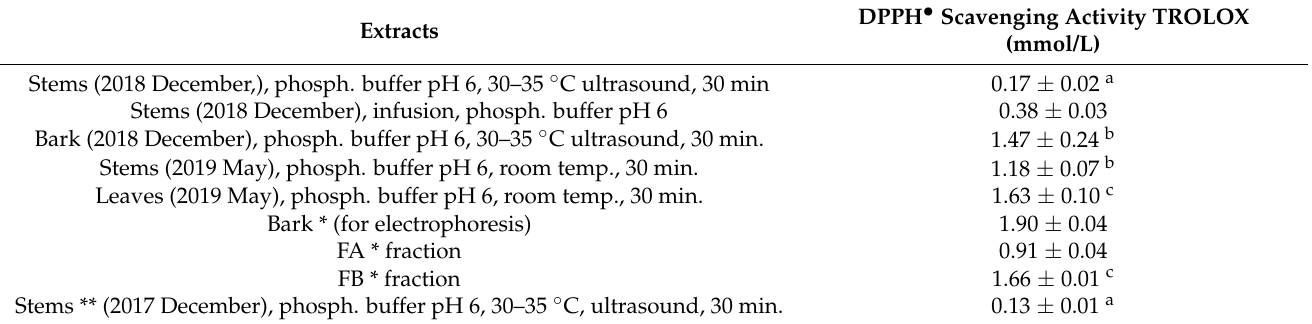
DPPH • Scavenging Activity